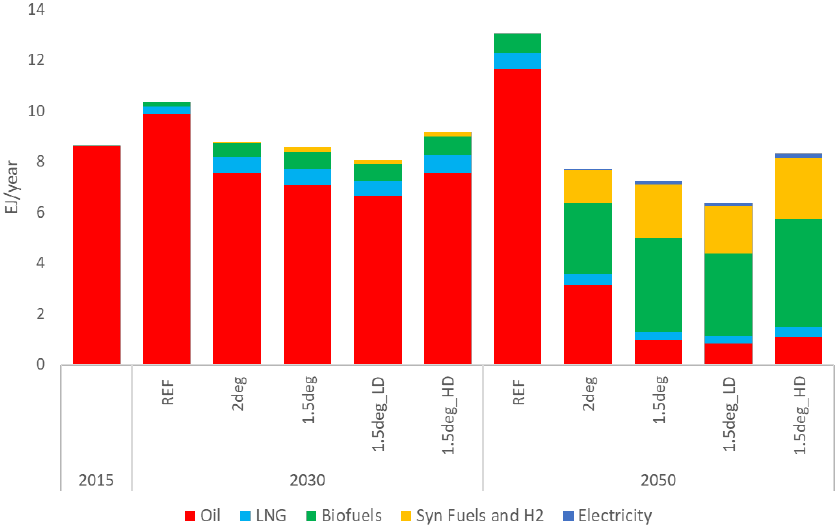
Figure 10. Energy consumption by fuel for international shipping in 2030 and in 2050.